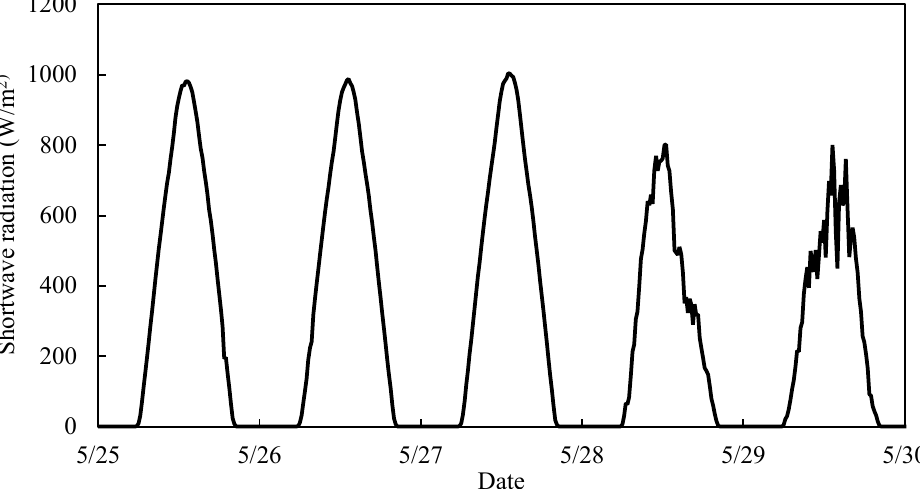
Figure 5. Shortwave radiation patterns measured by the standard automatic weather station during the